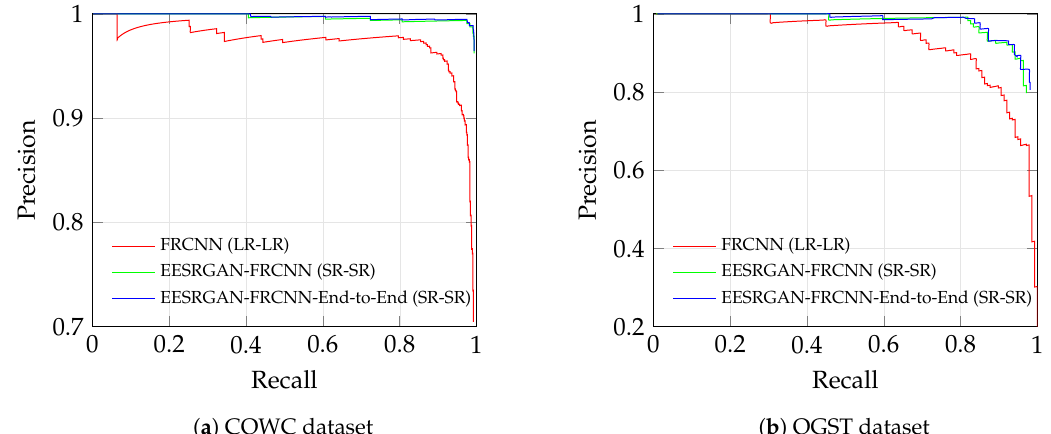
Figure 9. Precision-recall curve for the datasets. Plotted results show the detection performance of standalone faster R-CNN on LR (low-resolution) images and our proposed method (with and without end-to-end training) on SR (super-resolution) images.